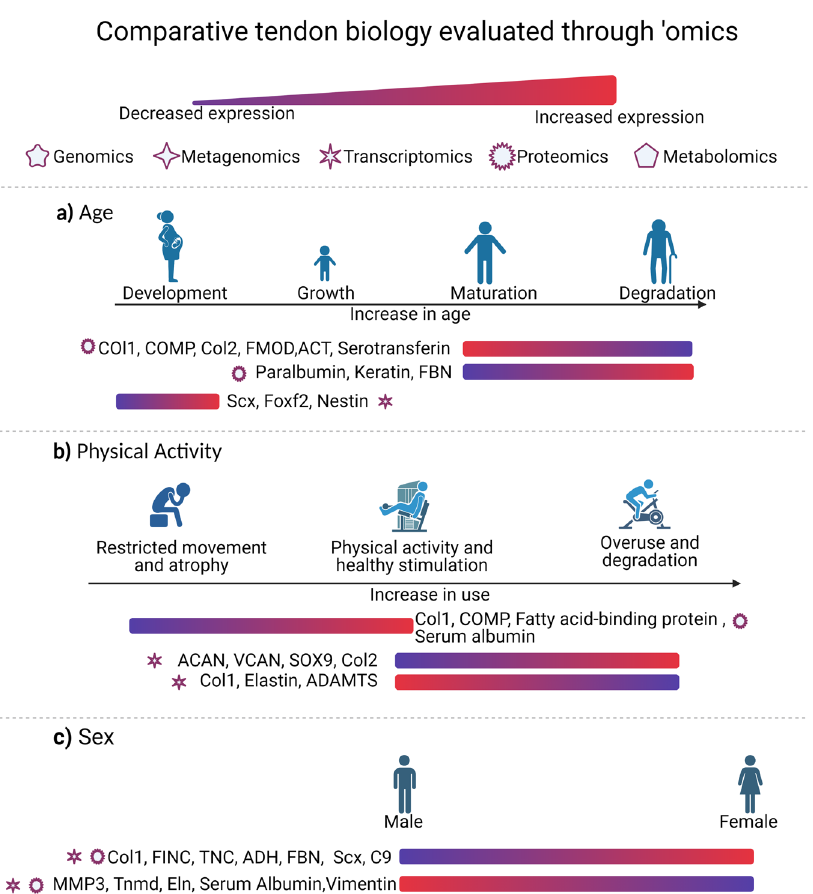
Fig. 2 Comparative metabolic evaluation of biological differences already identi fi ed in tendon through ‘ omic techniques (citations in text) according to different demographics. a Age, b physical activity and c sex. Collagen (COL); cartilage oligomeric matrix protein precursor (COMP); fi bromodulin (FMOD); actin (ACT); fi brillin (FBN); scleraxis (Scx); forkhead box protein F2 (Foxf2); aggrecan (ACAN); versican (VCAN); transcription factor SOX-9 (SOX9); a disintegrin and metalloproteinase with thrombospondin motifs (ADAMTS) fi bronectin (FINC); tenascin (TNC); alcohol dehydrogenase (ADH); complement component C9 (C9); matrix metalloproteinase 3 (MMP3); tenomodulin (Tnmd); elastin (Eln). Created in